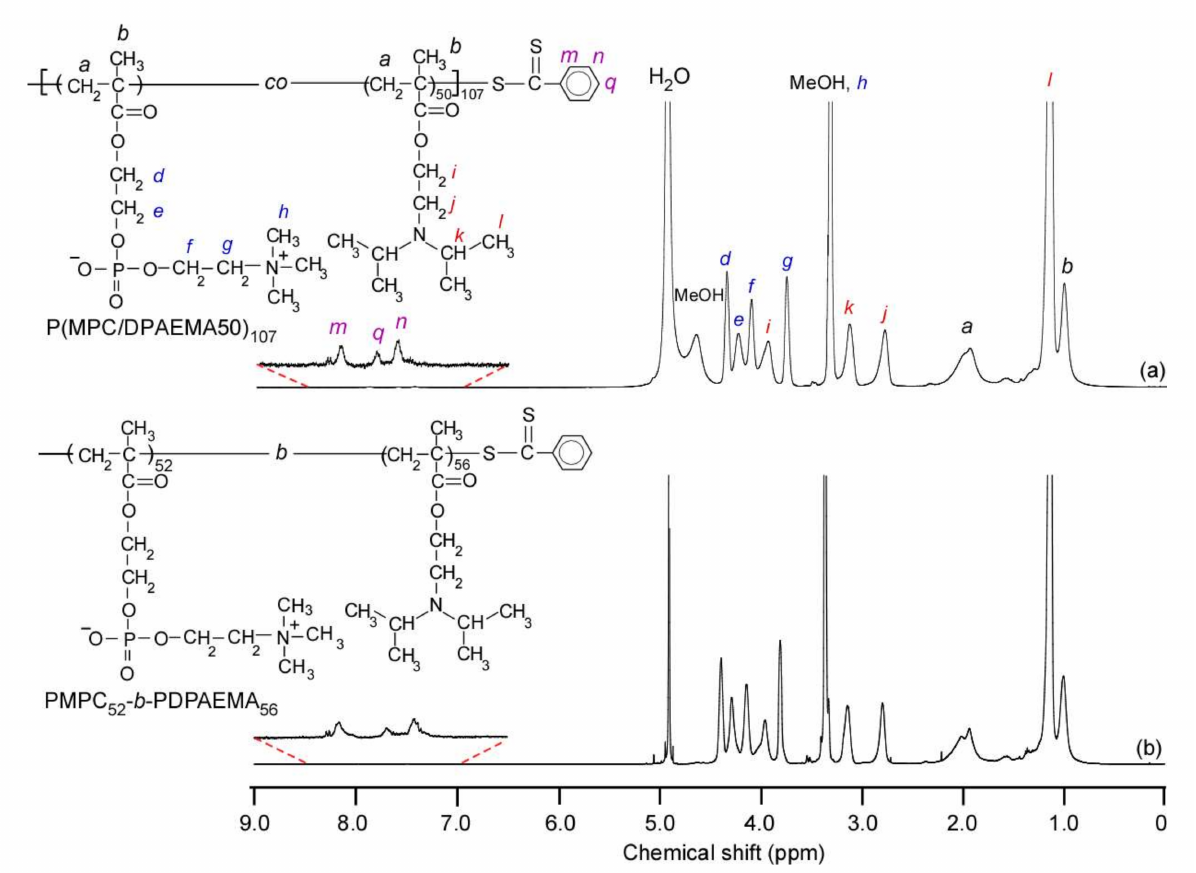
Figure 2. 1 H NMR spectra of ( a ) P(MPC/DPAEMA50) 107 and ( b ) PMPC 52 - b -PDPAEMA 56 in methanol- d 4 at 25 ◦ C. Table 1. Number-Average Molecular Weight ( M n ), and Molecular Weight Distribution ( M w /M n )